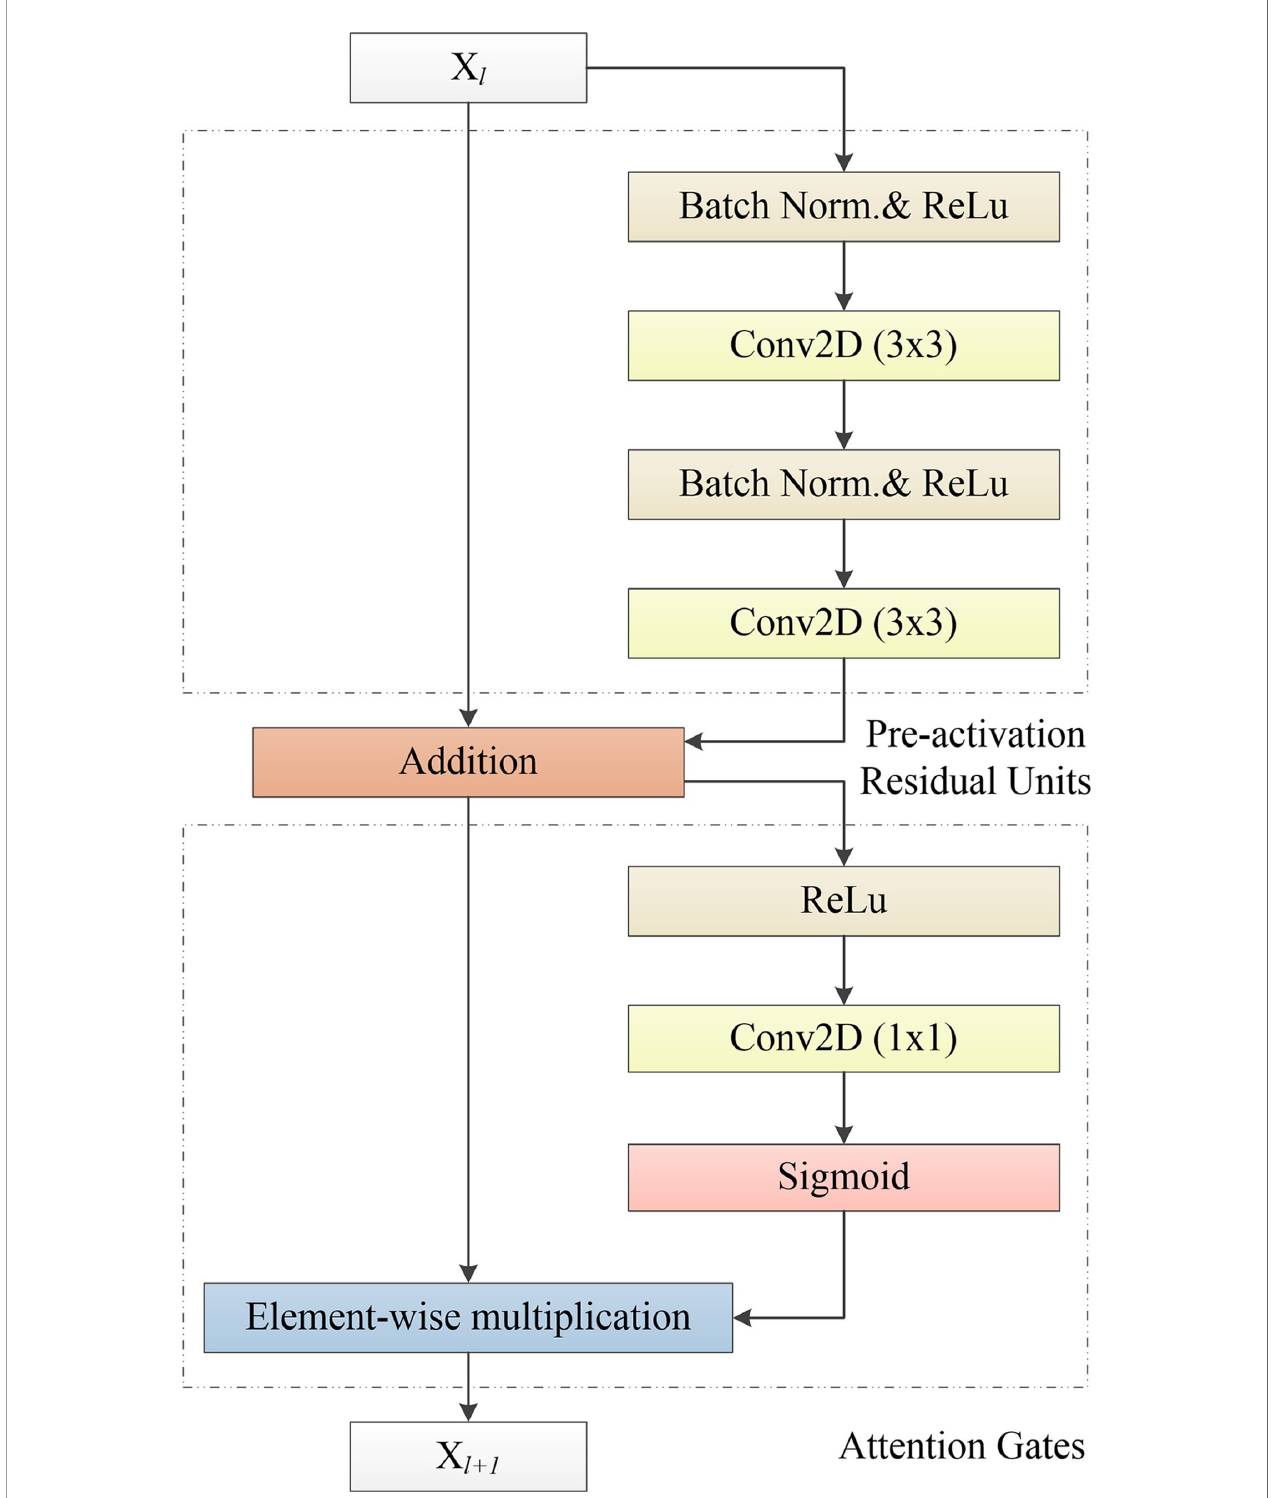
FIGURE 4 | Our proposed APR module, which consists of the Pre-activation Residual Units and Attention Gates. Pre-activation Residual Units obtain feature maps of low-level and high-level scales. Attention Gates obtains the weighted feature map of the 2D image by performing nonlinear processing on the output result of the Pre-activation Residual